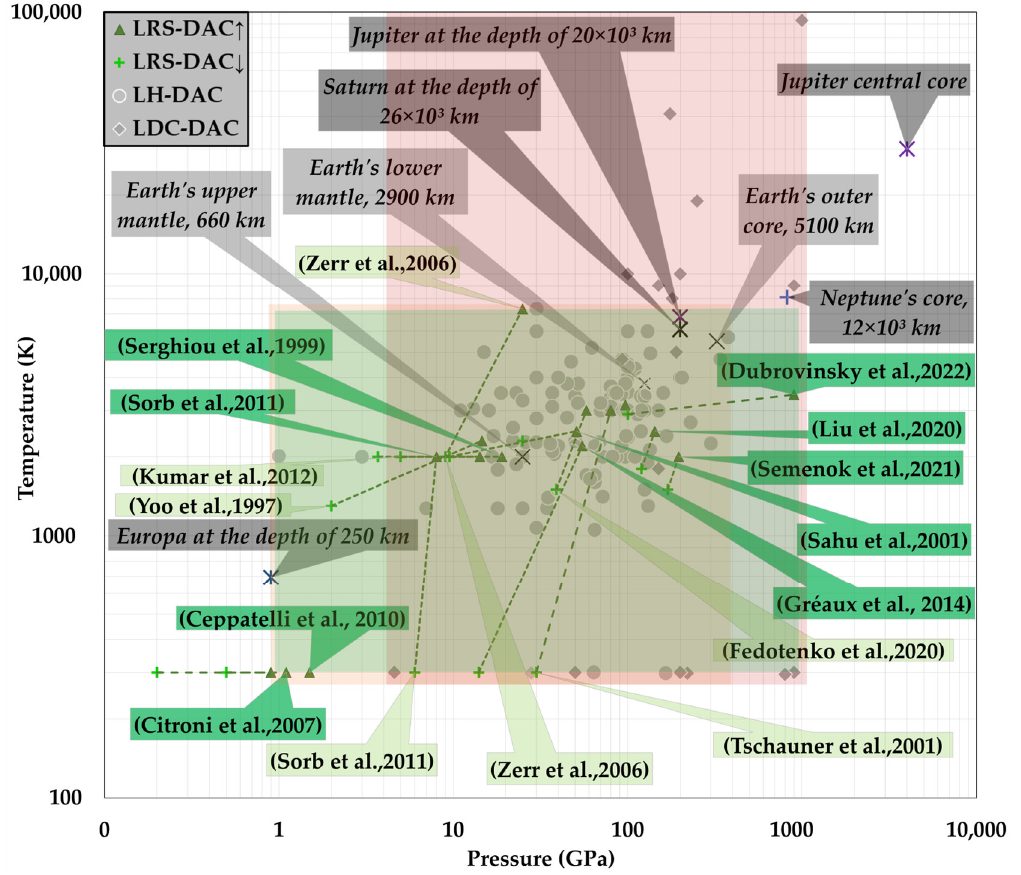
Figure 4. (A-Green) Peak P-T Map of LRS-DAC experiments [14,19,56,61,74,76–80,84,96–104], as contrasted with other L-DAC methods, such as: (B-Orange) LH-DAC experiments [28,29,73,105–220] and (C-Red) LDC-DAC experiments [46,221–227]. For reference, several P-T conditions are provided, including: 250 km down in Europa’s oceans [228]; 660, 2900, and 5100 km below the Earth’s surface [136,190,221]; 12 × 10 3 km deep within Neptune’s core [229]; 26 × 10 3 km deep inside Saturn’s liquid- hydrogen mantle [230]; and 20 × 10 3 km deep in Jupiter’s upper atmosphere [231].